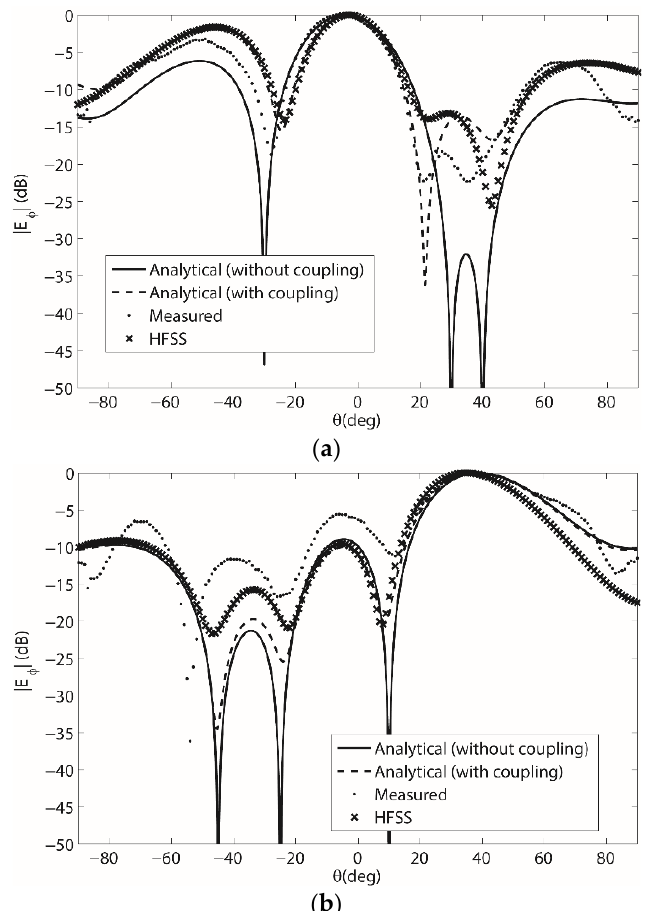
Figure 8. ( a ) Pattern 1 beamforming results for the 1 × 4 microstrip patch array on the cylindrical curvature surface with r = 10 cm; ( b ) Pattern 2 beamforming results for the 1 × 4 microstrip patch array on the cylindrical curvature surface with r = 10 cm.